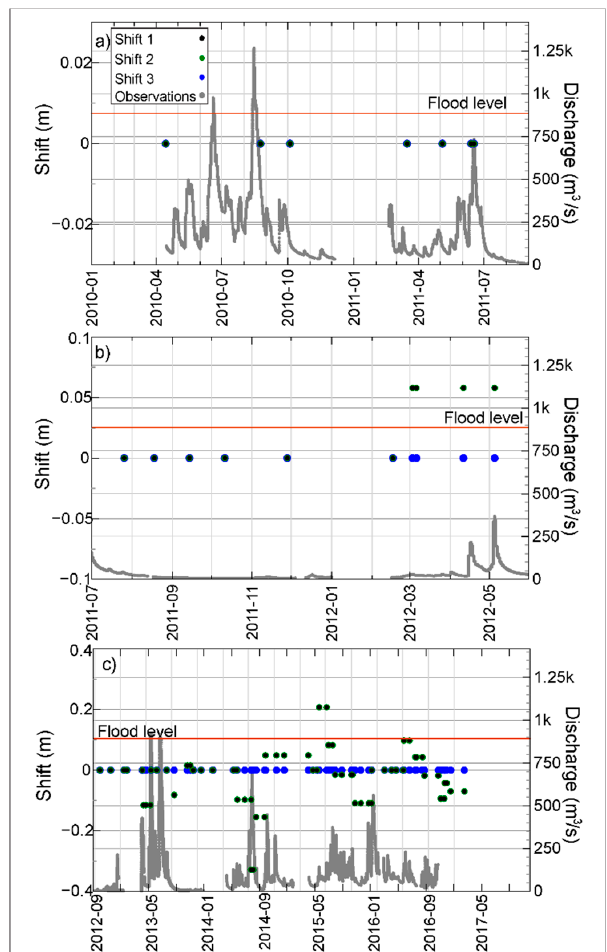
Figure 12. Shift values plotted with hydrograph data in Skunk River at Merrimac. Black, green, and blue dots represent the shift values applied to the section, channel, and overbank control areas, respectively. ( a ) Hydrograph for base rating curve #1.0; ( b ) hydrograph for base rating curve #2.0; and ( c ) hydrograph for base rating curve #3.0.